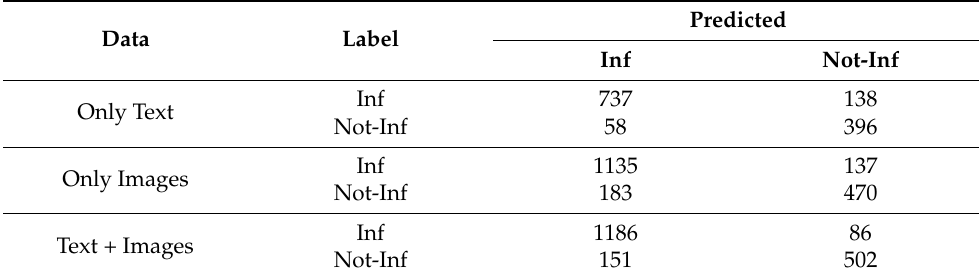
Table 11. Confusion matrix of the three models on Task 1. Inf represents informative. Not-Inf represents not informative.